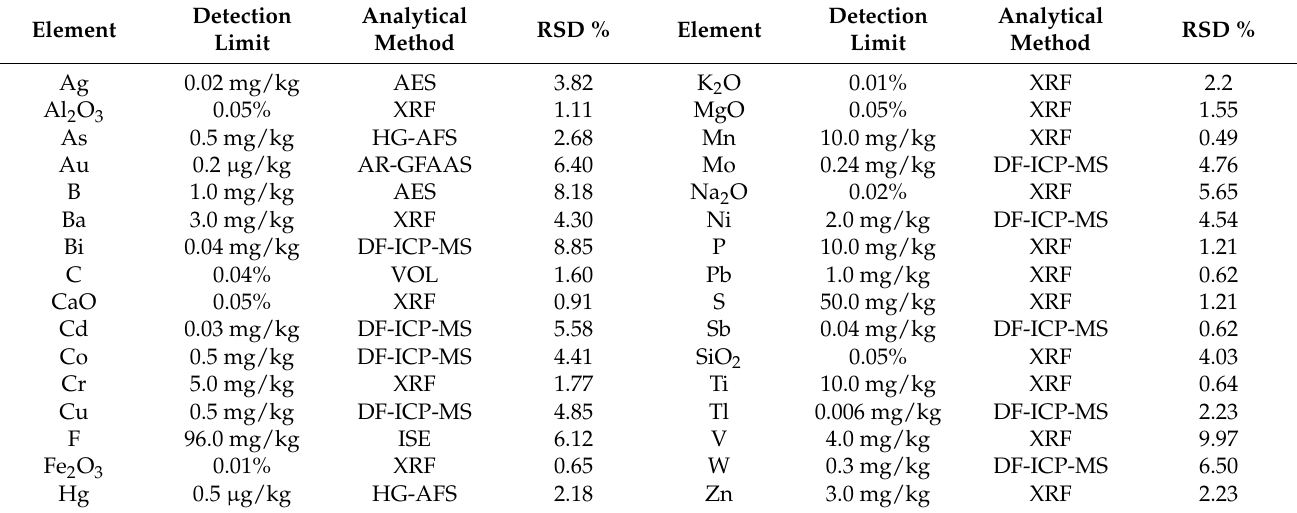
Table 2. Analytical methods used for the determination of major and trace